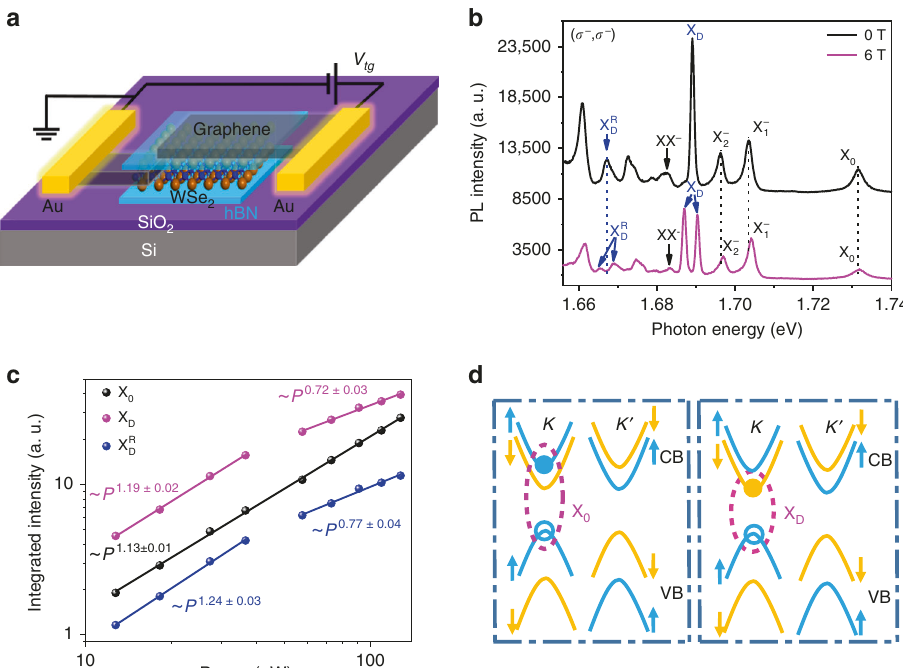
Fig. 1 Dark exciton PL splitting in magnetic fi eld. a Schematic representation of BN encapsulated monolayer WSe 2 with graphene contact and top gate electrodes. b PL spectra of the device in ( a ) at 4.2 K without the application of the top gate voltage, with no magnetic fi eld (black) and with 6 T out-of-plane magnetic fi eld (magenta) applied. c Integrated PL intensity of WSe 2 as a function of the excitation power for the X 0 , X D and X R con fi gurations of exciton and dark-exciton states with the solid and empty dots representing the electron and hole. Blue and orange colors stand for spin-up and spin-down bands, respectively